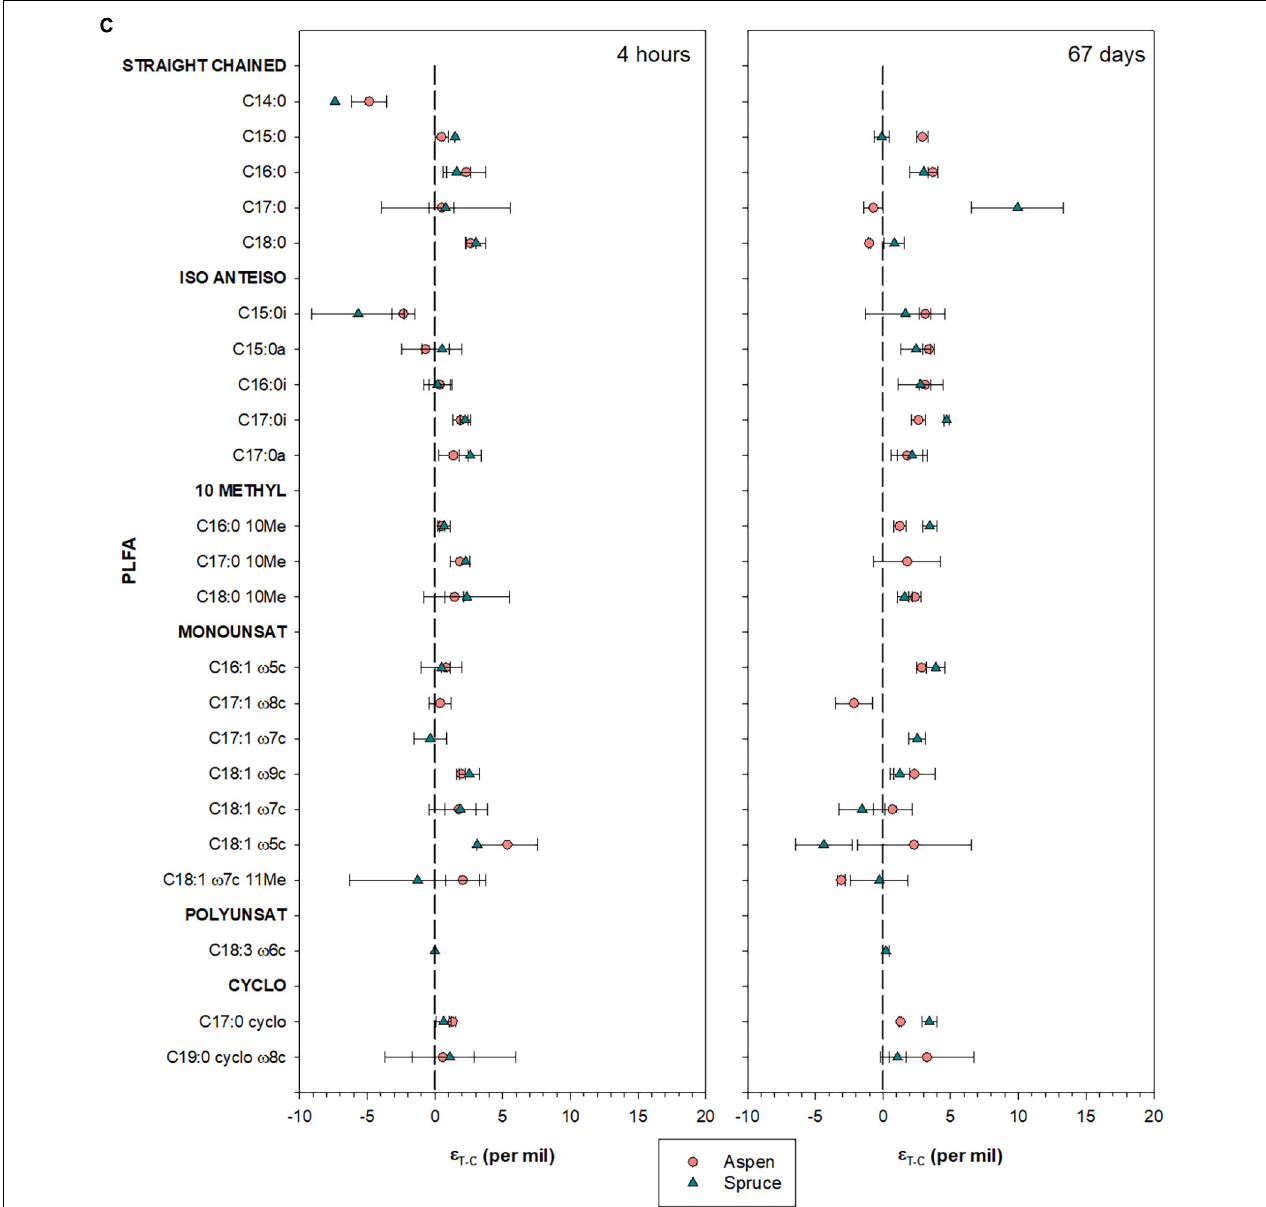
FIGURE 4 | Differences in isotopic composition of selected PLFA biomarkers ( ε T − C ) between substrate-amended and control incubation units after 67 days of incubation. Results are presented for both aspen and spruce soil incubation units, and added substrates included: glucose (A) , aspen leaves (B) , and aspen roots (C) . Average values are presented with standard deviations over five experimental replicates. However, for some PLFAs, only one reliable measurement could be obtained with GC-C-IRMS analysis, and results are presented as a single point with no standard